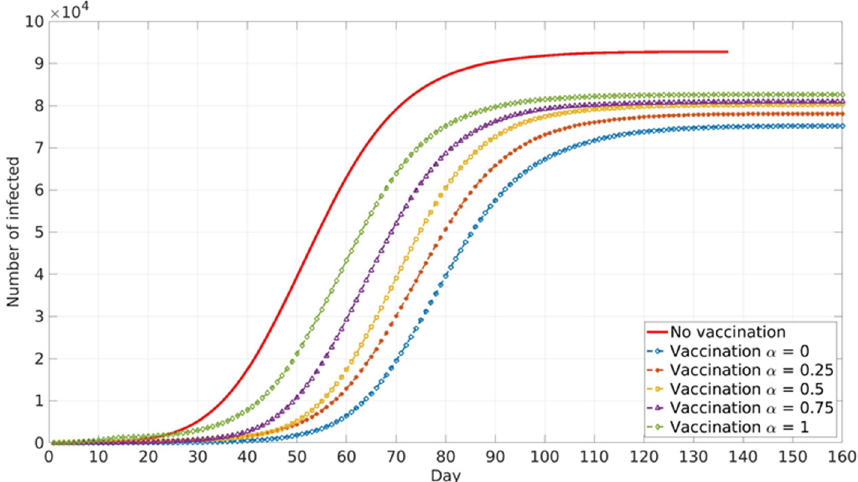
Figure 6. Vaccinated healthcare workers in the COVID system and adults over 65 years. The model predicted cumulative numbers of infected cases depending on social parameter α .